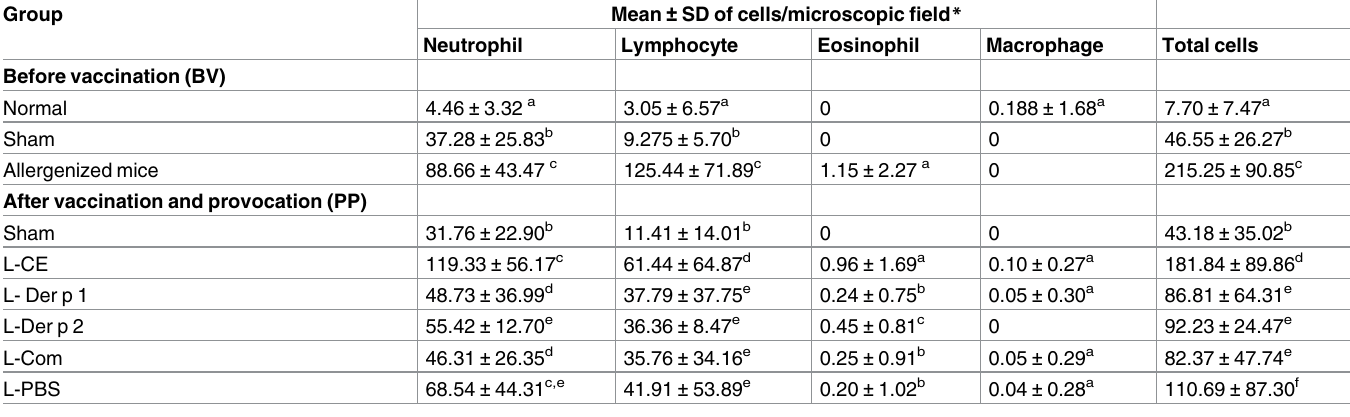
lated vaccines and placebo are shown in Table 2. Micelles of all vaccines and placebo were Table 1. Inflammatory cells in lungs of Dp-CE allergic mice compared with normal and sham mice before vaccination (BV) and after vaccination/ placebo and provocation with Dp-CE